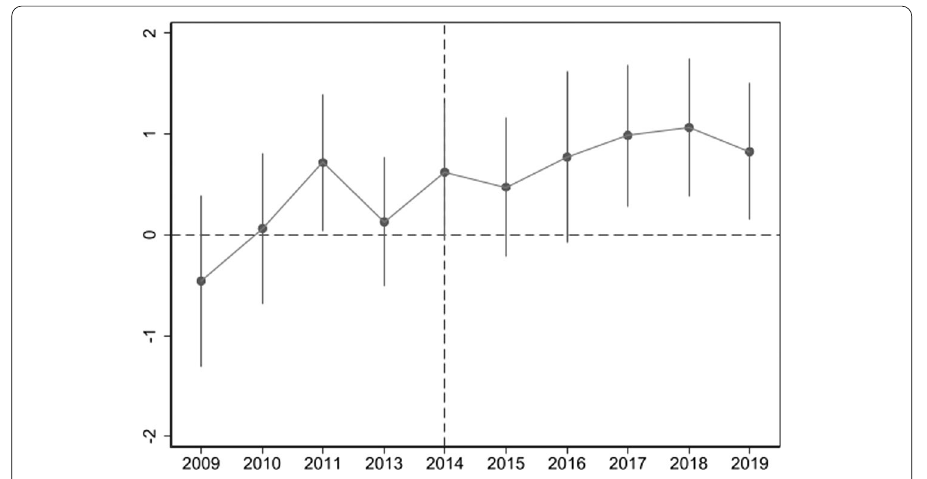
Fig. 3 Downstream conduction effect and parallel trend test